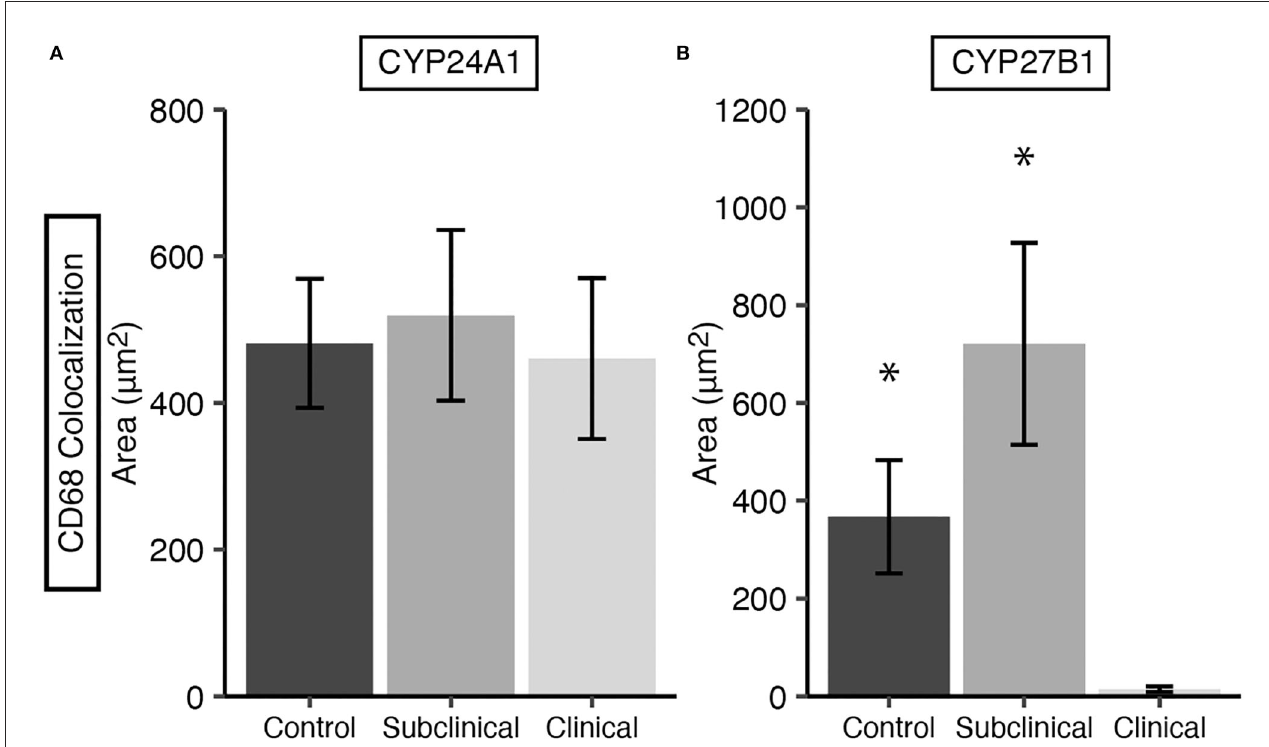
FIGURE7 CYP24A1 (A) and CYP27B1 (B) expression within macrophages in frozen tissue sections from bovine mid-ileum. Expression was measured by CYP colocalization with CD68. Cows were stratified into groups by natural MAP infection (clinical n = 10, subclinical n = 10) or JD- controls ( n = 10). Data are presented as the mean fluorescence area µ m 2 ± SE. Significance is indicated as * < 0.05 compared to the clinical group.